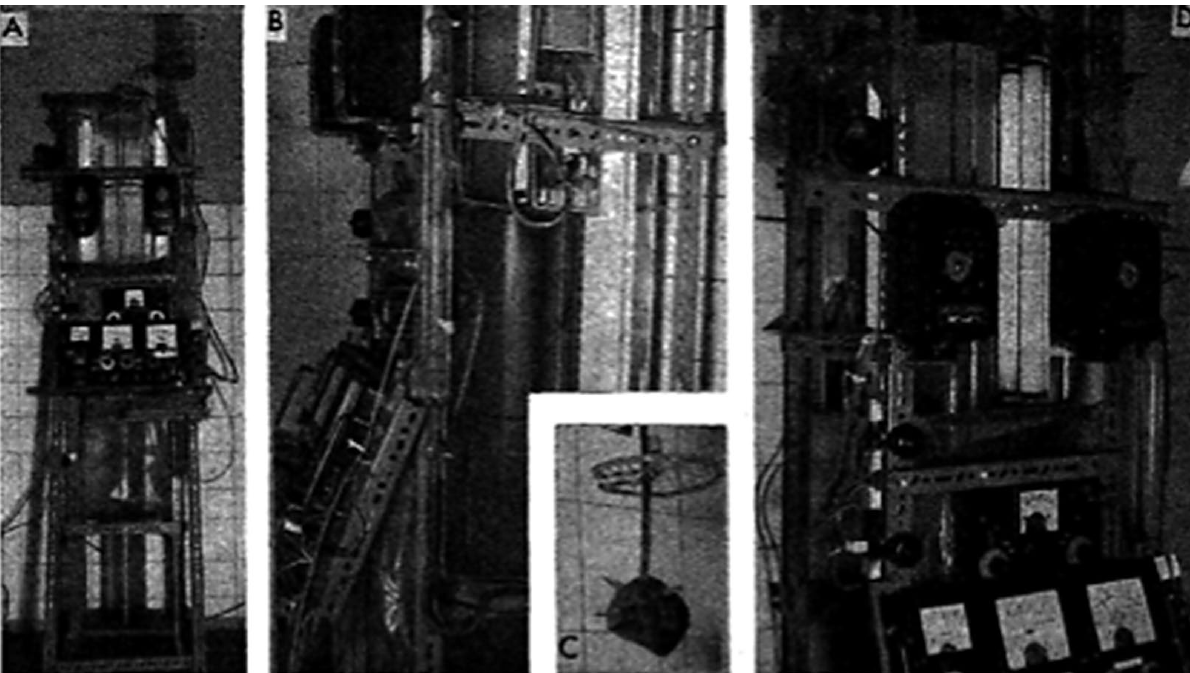
Fig. 16. – Details of the physical analogues of the marine water column (laboratory microcosms) for the study of the ecophysiology, pigment composition and depth distribution characteristics of phytoplankton in relation to the vertical profiles of temperature gradients (thermocline), light intensity, nutrients and turbulence. The culture conditions could be automatically controlled. More details in Margalef